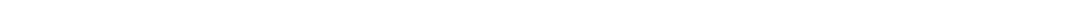
Table 4. List of current metrics and associated variables. Metrics being used to evaluate the performance of the Open Science and Data Collaborations (OSDC) program and the variable(s) that are used to calculate each one. Metrics are organized using a “ 5W1H ” (Who, What, When, Where, Why, How) framework representing the major classes of query the dataset is designed to answer. Data for each metric can either be collected directly from dashboards, vendors, or registration records, or derived from the direct data with simple